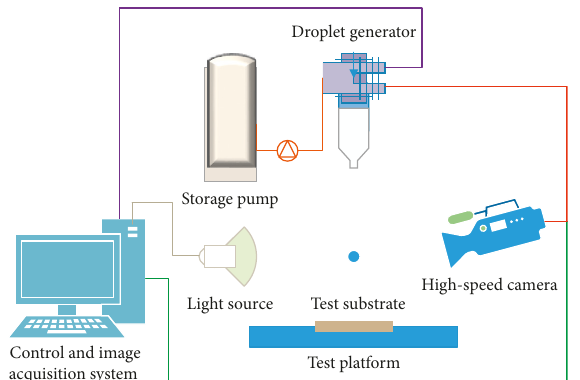
Figure 9: Schematic diagram of the single-drop substrate impact test